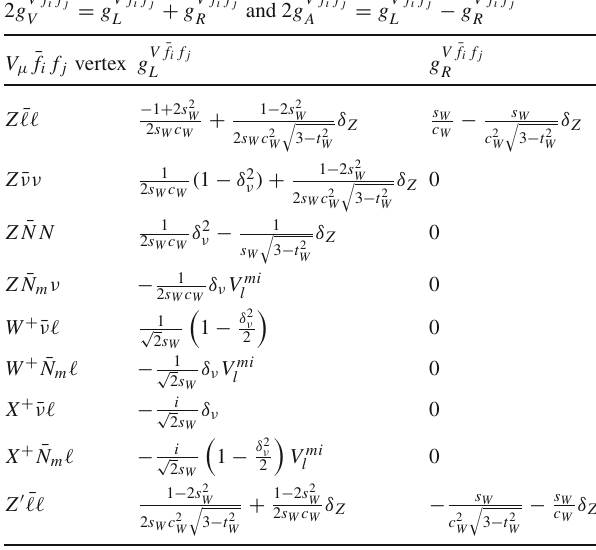
Table 4 Feynman rules for the vertices of a gauge boson to a lepton pair V μ ¯ f i f j . The Feynman rule for this class of vertices has the generic ¯ f i f j form ie ( g V